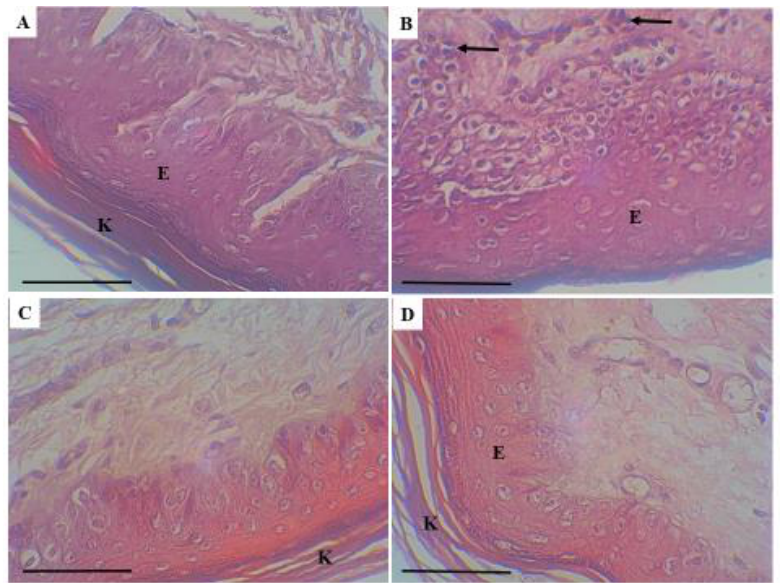
Figure 6. Histopathological assessment of inflammation in the skin of rats. Photo ( A ): negative control, ( B ): Positive control, ( C ): Diclofenac treated, and ( D ): γ -lactone treated. E: epidermis, arrows: inflammatory cells infiltration, K: Keratinous layer. Scale bar: 100 μm. H&E s tain.